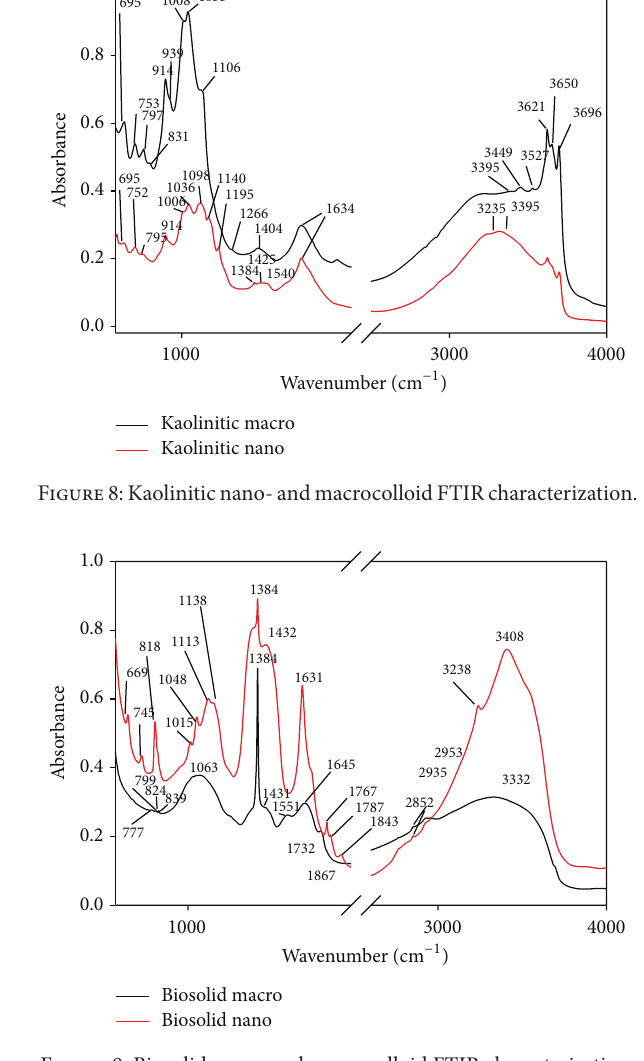
Figure 7: Mixed mineralogy nano- and macrocolloid FTIR charac- terization.